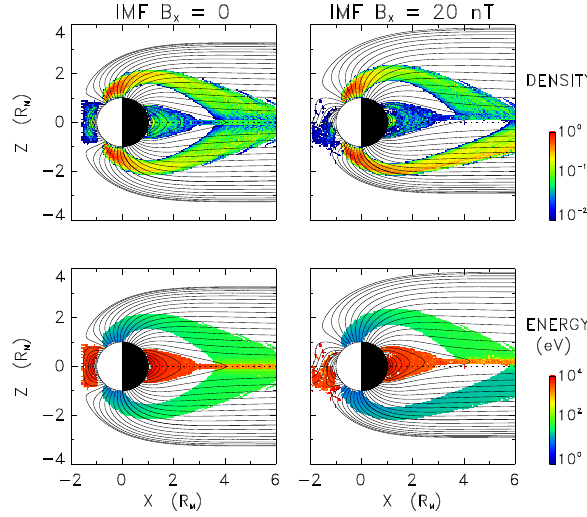
Fig. 7. Identical to Fig. 6 but for